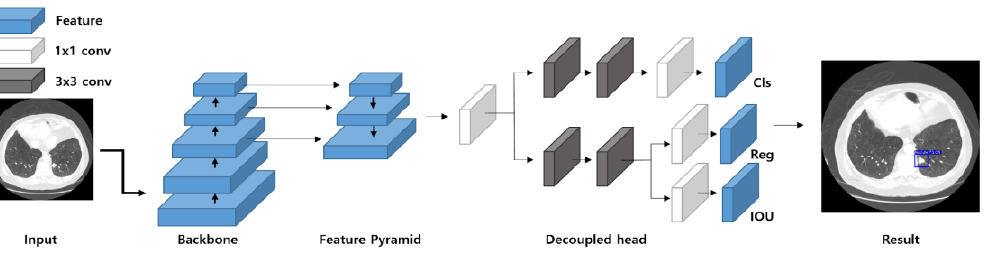
Figure 4. Detailed architecture of YOLOX. Cls, Class; Reg, Regression; IOU, intersection over union; conv, convolution. conv,